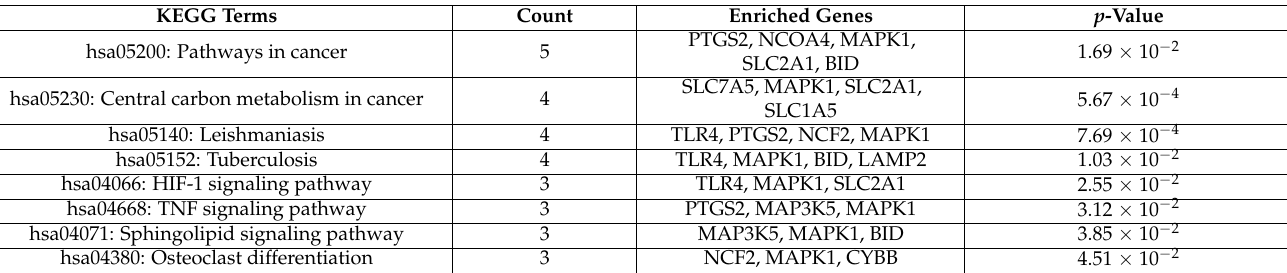
Table 2. KEGG pathway analysis of 27 ferroptosis-related differentially expressed genes in GIONFH and non-GIONFH